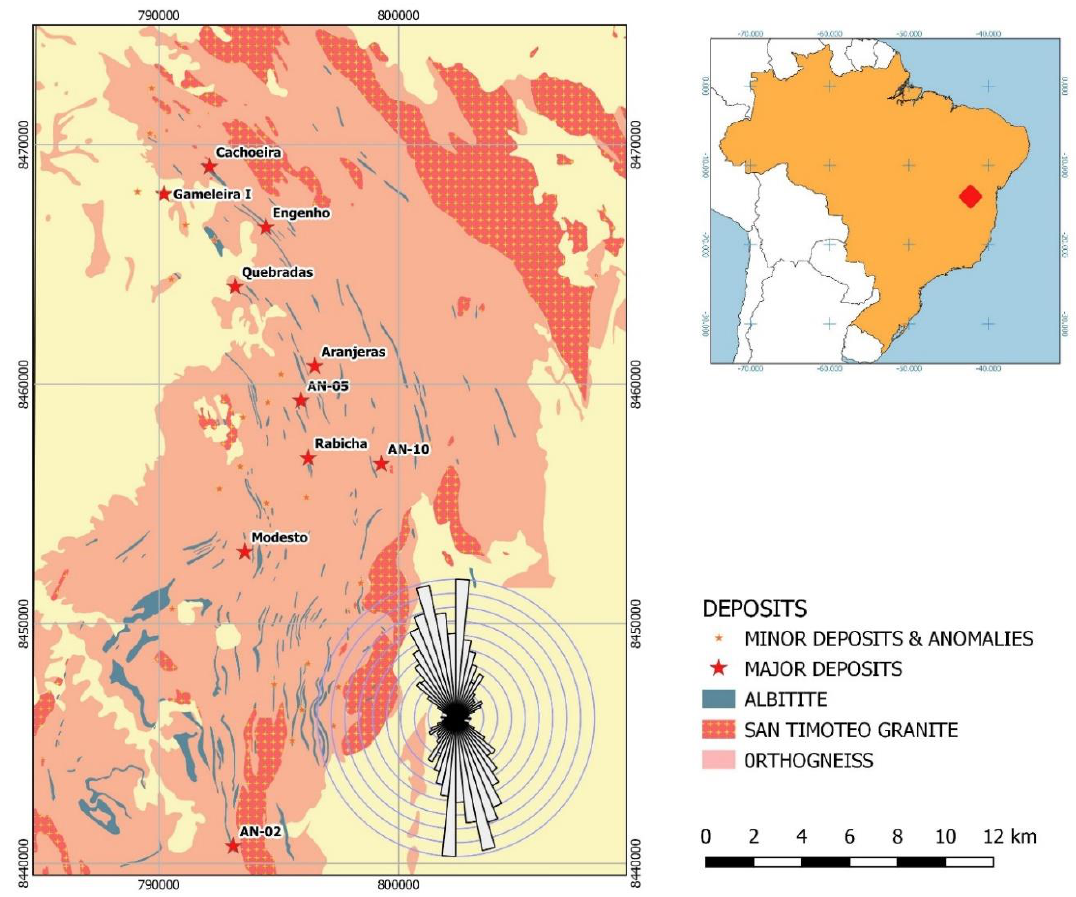
Figure 3. Simplified geology of the Lagoa Real district [9]. The rose diagram shows the trends of over 180 discrete albitite bodies.